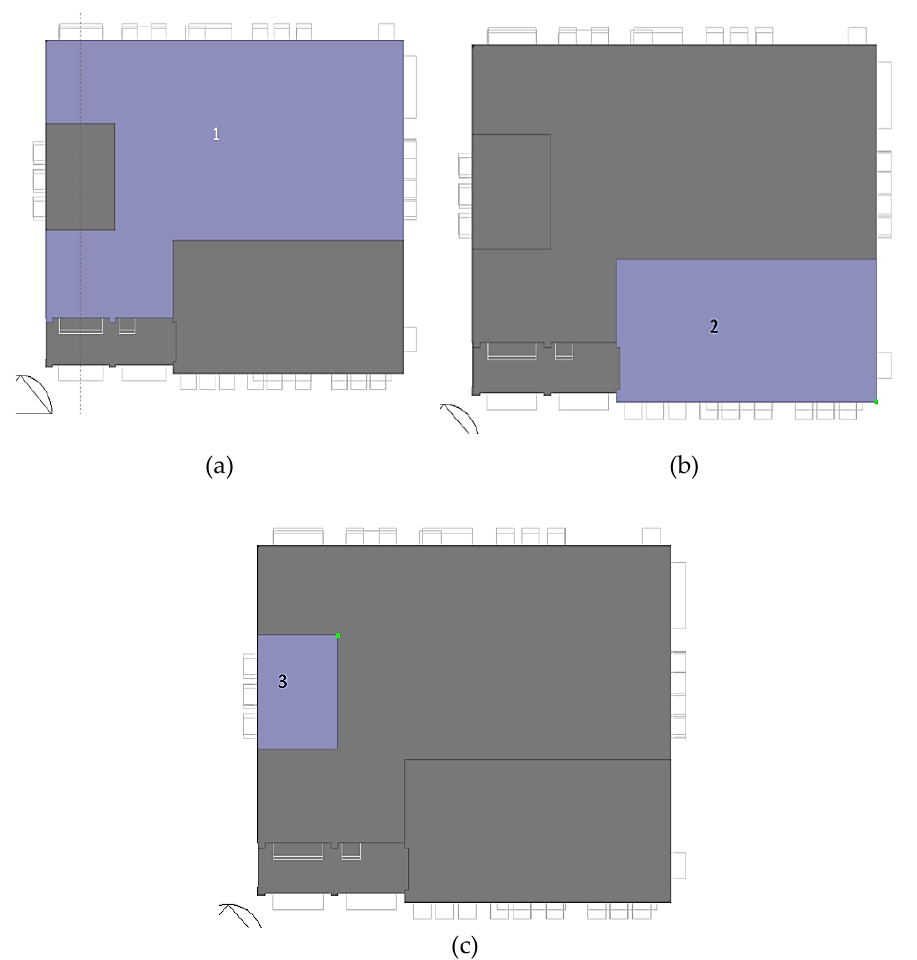
Figure 9. ( a ) The first part of roof for installing PV panels. ( b ) The second part of roof for installing PV panels. ( c ) The third part of roof for installing PV panels.